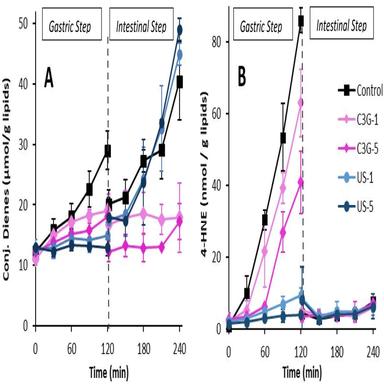
Inhibition by the DJP-US extract and pure C3G of the accumulation of (A) lipid-derived conjugated dienes (CD) and (B) 4-HNE during the in vitro simulated digestion of phospholipid-stabilized emulsions. US-1 and C3G-1 bring 14.9 µg total anthocyanins while US-5 and C3G-5 74.4 µg. Lipid oxidation was initiated by metmyoglobin (30 µM). Values represent mean ± SD (n = 3–7).